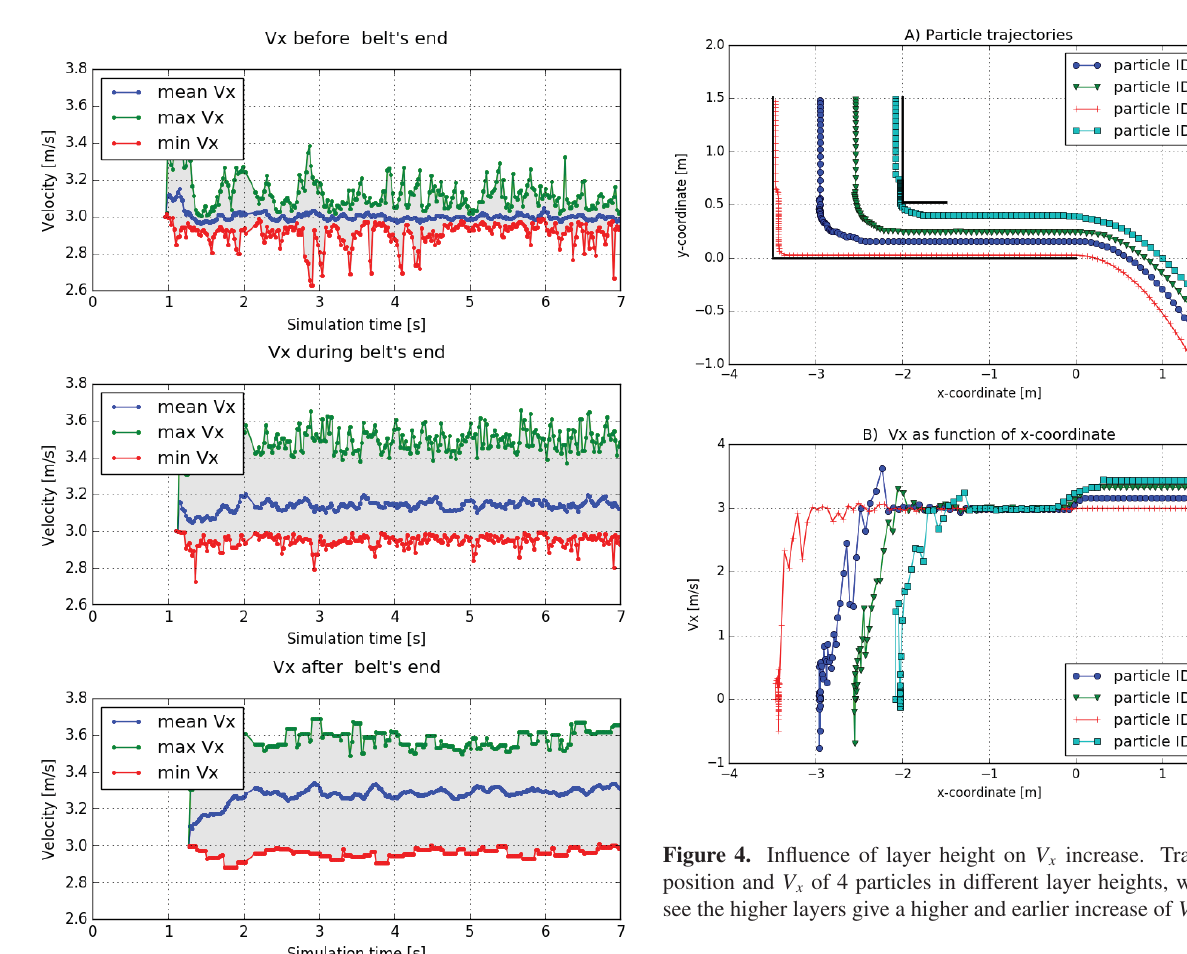
Two values for belt slope ( + 5 ◦ and -5 ◦ ) were tested